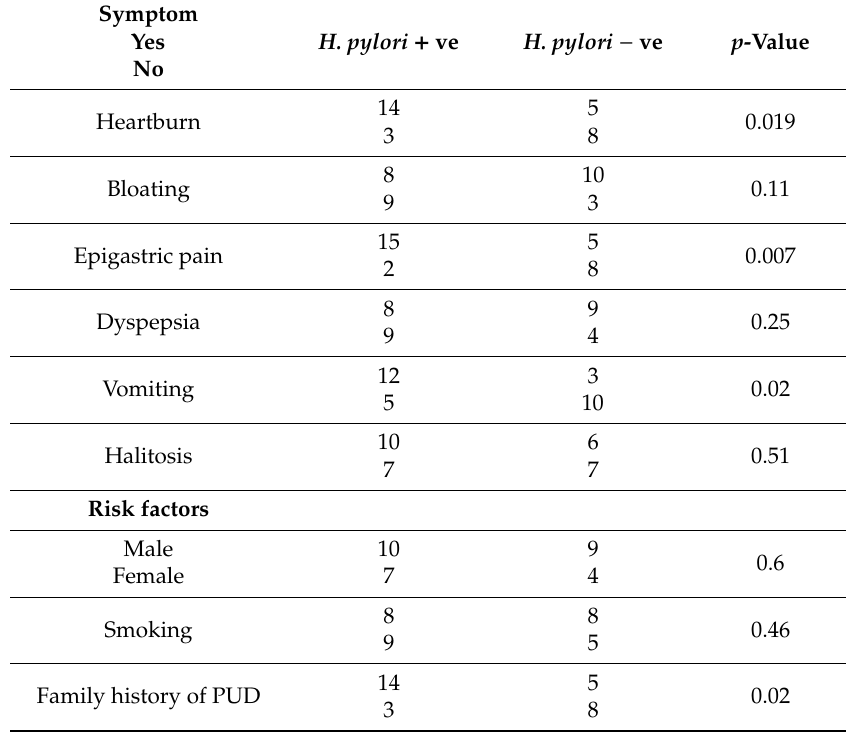
Table 2. Main complaints and risk factors among patients diagnosed using